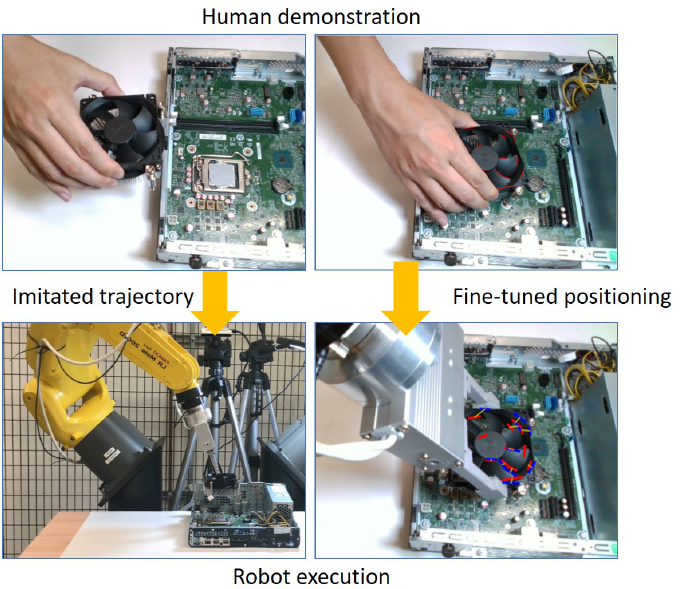
Figure 1. Overview of the proposed Programming by Demonstration approach. An imitated trajectory is generated by tracking human hand movements, as well as the visual features are collected and used for high-precision positioning through the use of visual